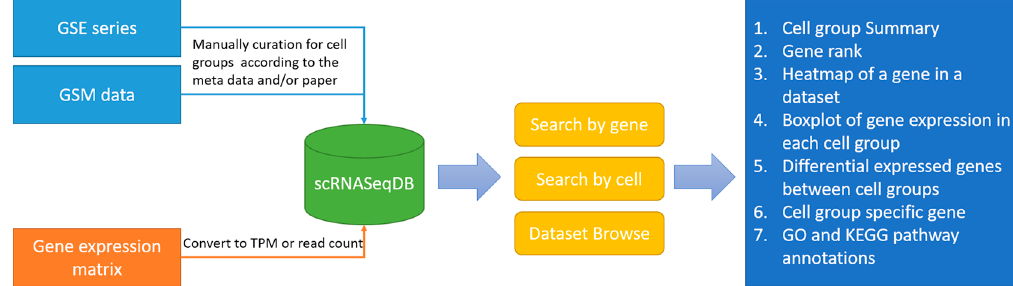
Figure 1. Flowchart of data collection and database construction. GSE: accession number of series; GSM: accession number for samples; TPM: Transcripts Per Million.